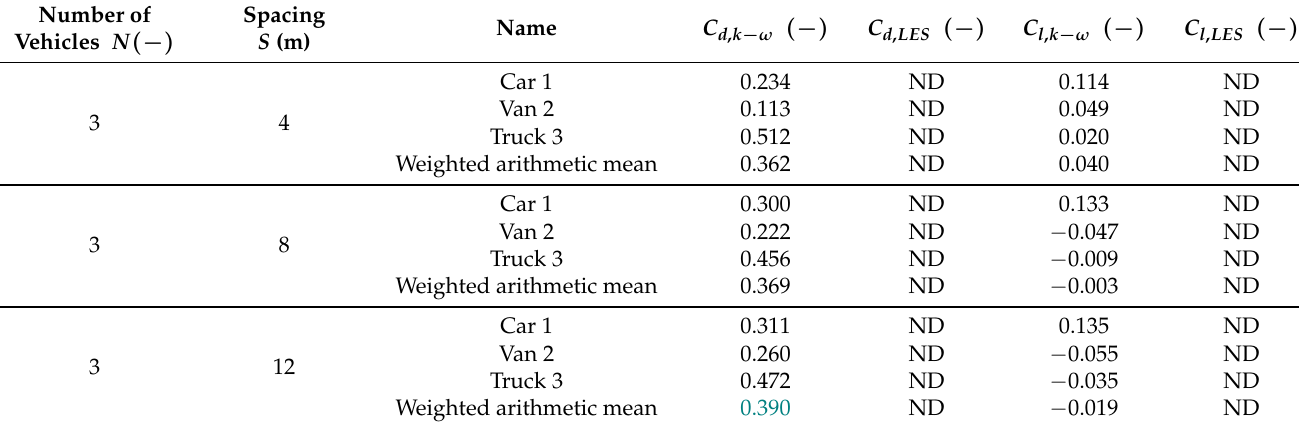
Table A2. Drag coefficient and lift coefficient of vehicles in heterogeneous columns (Car–Van–Truck).